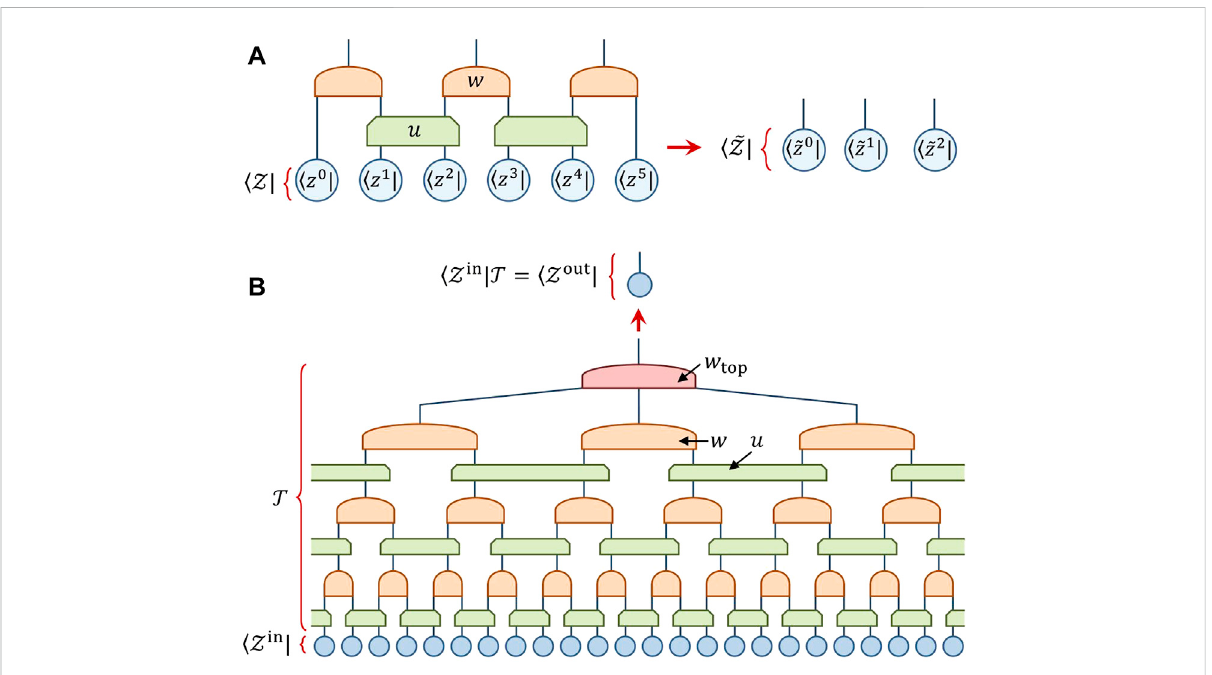
FIGURE 2 (A) Anumber-statepreservingnetwork isformedthroughcompositionofnumber-state preserving tensors u and w ,which mapsinput